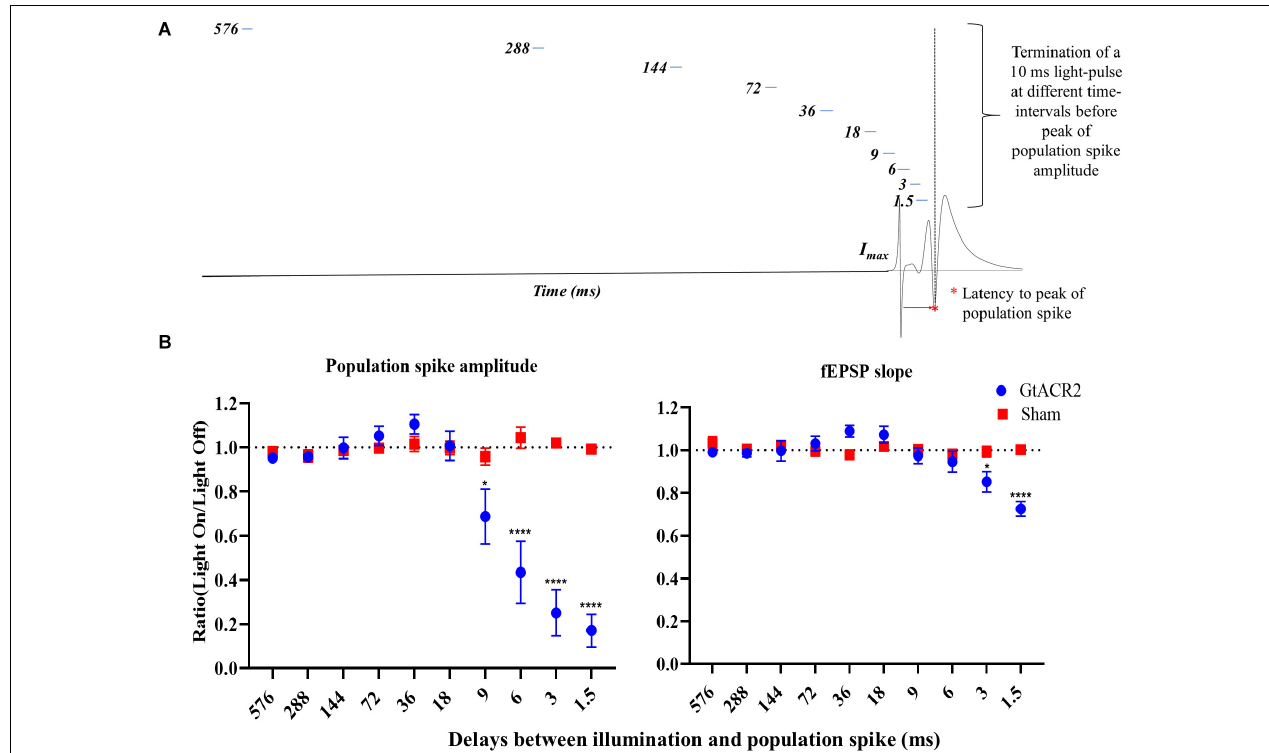
FIGURE 4 | Effect of delays between illumination and CA1 EPs. (A) Schematic of the experimental paradigm. (B) The inhibitory effect of activating GtACR2 on population spike ( n = 5) and fEPSP slope ( n = 4) of CA1 EPs decreased when increasing the delay between a 10 ms light-pulse and PS peak. Mean of the ratios (light-on/light-off) and standard error of the mean (SEM) for the EP parameters are plotted. * p ≤ 0.05 and **** p <